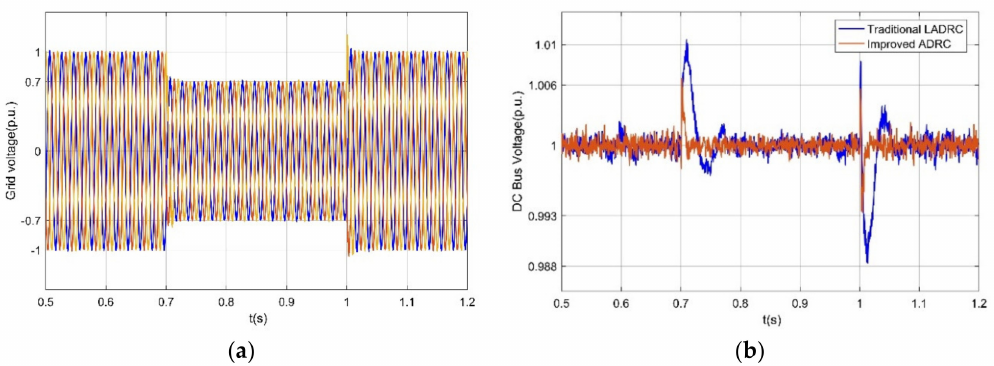
Figure 14. Power network voltage waveform and DC link voltage waveform when the power network voltage drops by 0.3 p.u. symmetrically: ( a ) Waveform of the power network voltage; ( b ) Waveform of the DC link